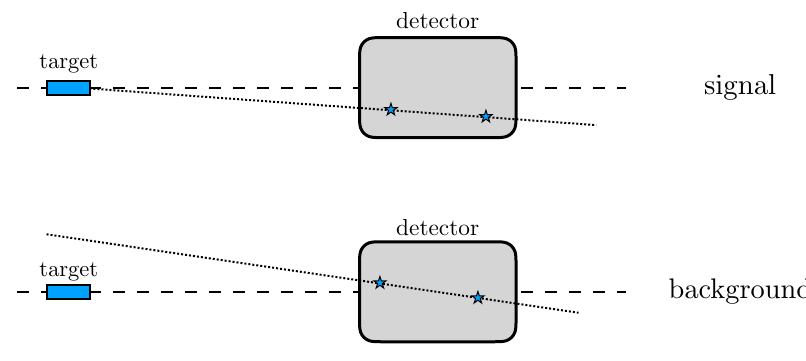
Figure 1 . In a signal double-hit event, the line that is de(cid:12)ned by the two hits will point to the target (top), whereas in a background double-hit event, it generically will not (bottom). Searching for double-hit events can thus lead to an enhanced signal to background